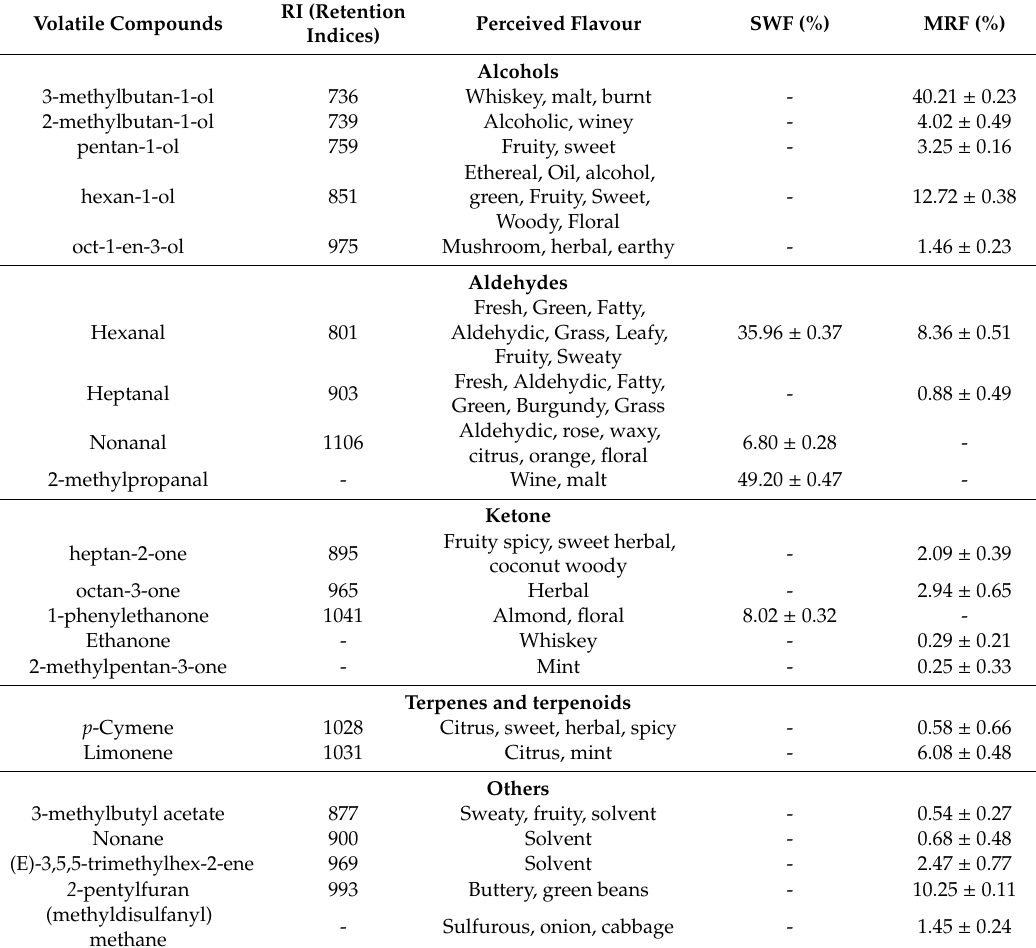
Table 3. Volatile compounds of spent malt rootlets flour (MRF) and whole wheat spelt flour (SWF) * . Volatile